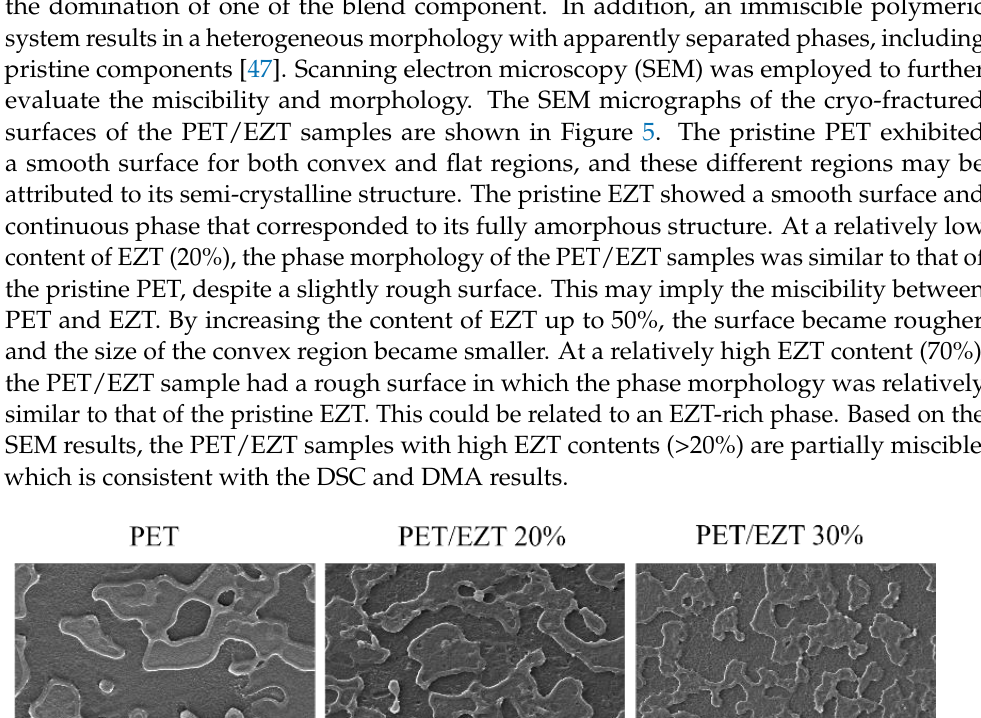
which is consistent with the DSC and DMA results.